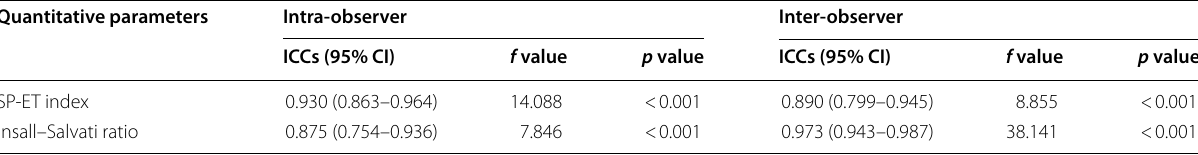
Table 2 The intra- and inter-observer agreement between two radiologists of quantitative MRI measurements Quantitative parameters